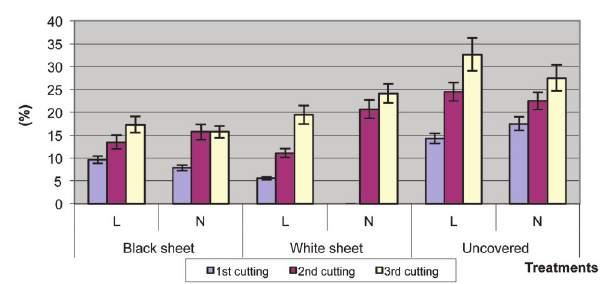
Figure 3. Rate of fungi infection (%) by different treatments